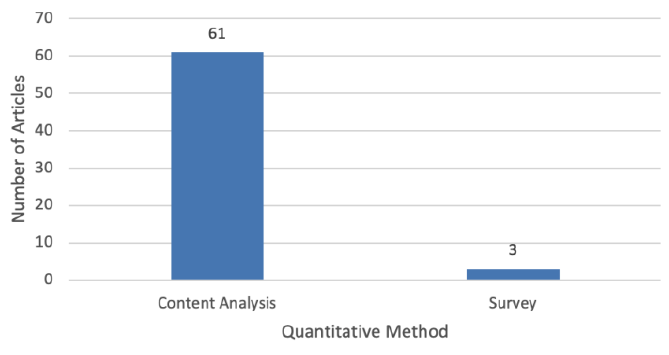
Figure 7: Research method